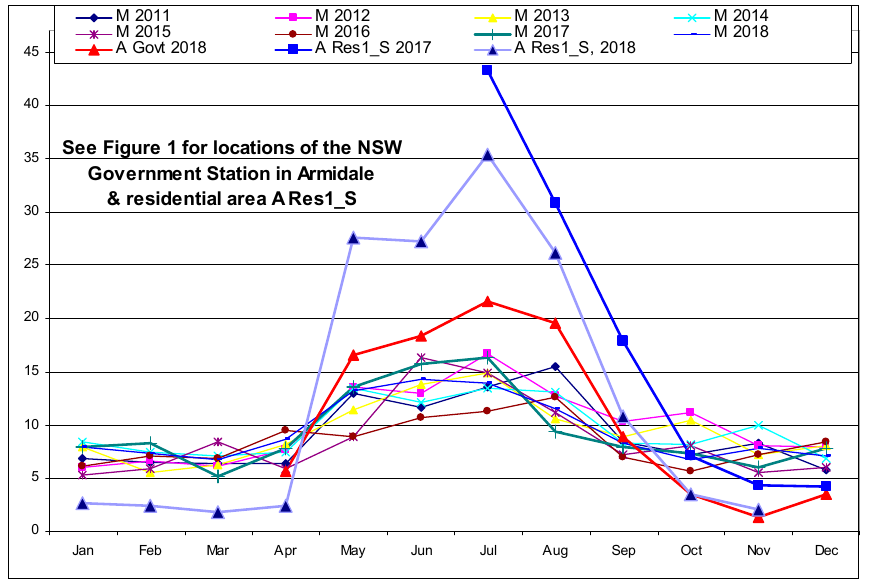
Figure 6. Monthly mean PM 2.5 measurements by year in (M) Muswellbrook and (A) Armidale at the NSW government stations and a residential area in Armidale in 2017 and 2018.